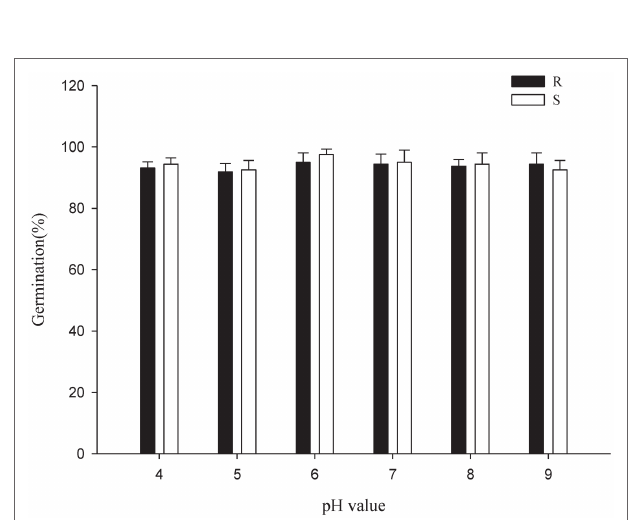
FIGURE 2 | Effect of osmotic stress on the germination of the different Polypogon fugax populations. Error bars represent standard error of the means. Values represent the mean of eight replications with 40 seeds per replication. The abbreviations R and S represent for the resistant and sensitive P. fugax populations, respectively.